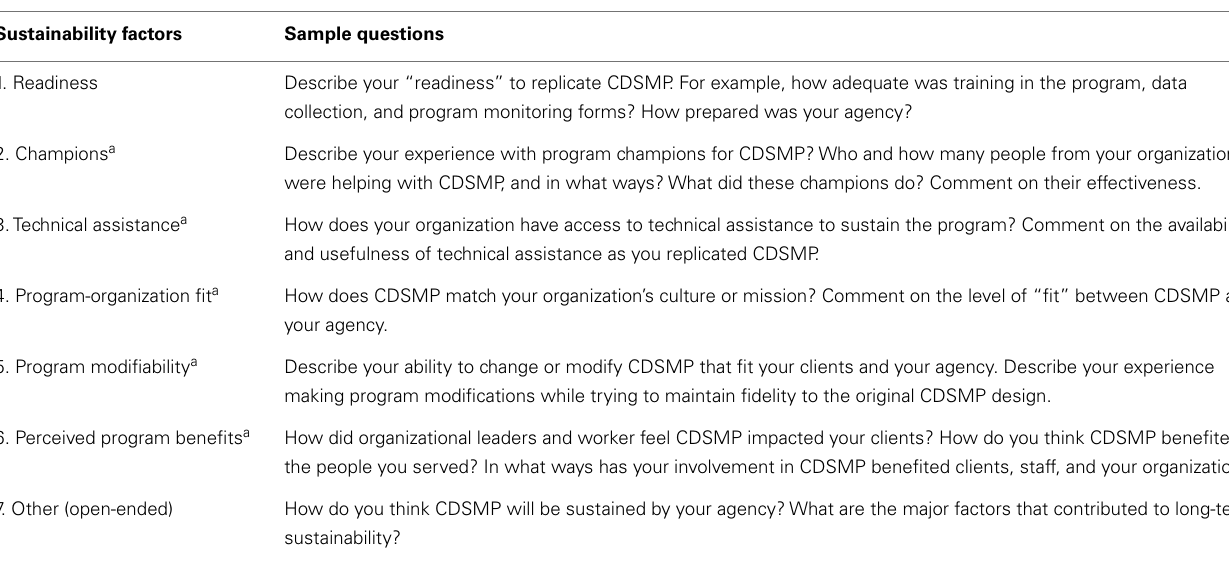
Table 1 | Summary of sustainability factors assessed